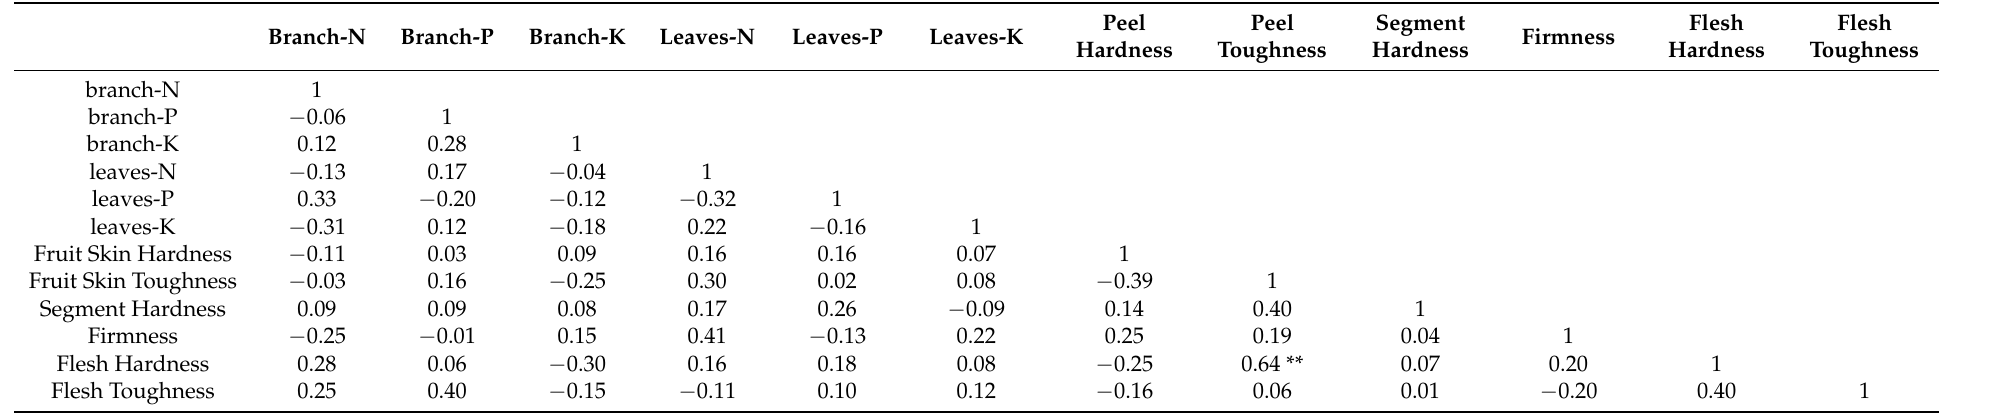
Table 5. Pearson correlation coefficient matrix of NPK content in branches and leaves and fruit texture indicators under different fruit load treatments. Branch-N Branch-P Branch-K Leaves-N Leaves-P Leaves-K